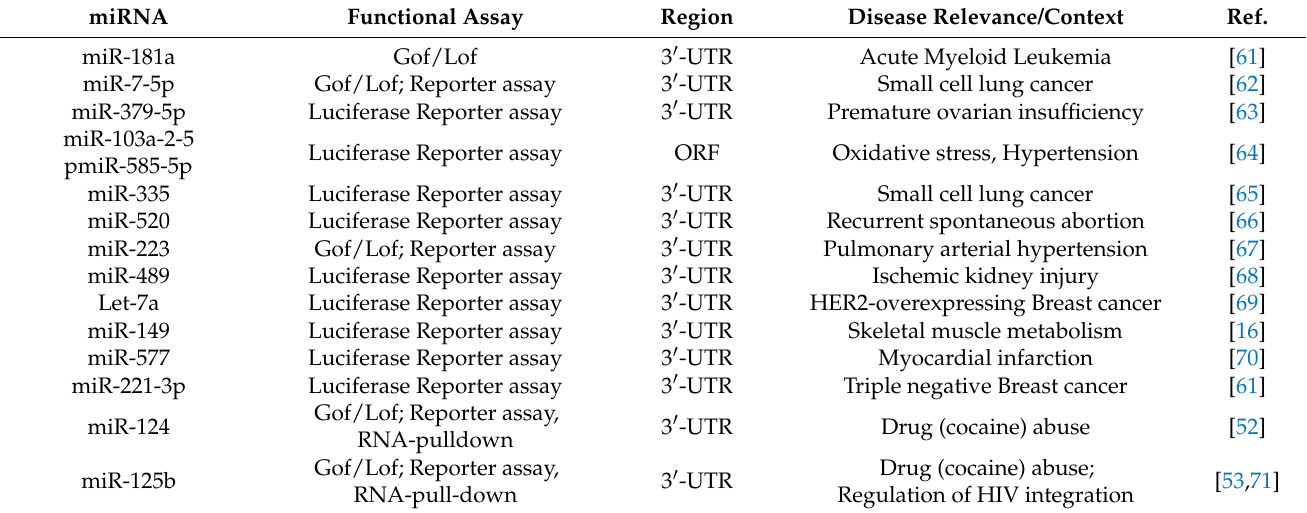
Table 1. List of functionally validated cellular microRNAs that regulate PARP-1mRNA in the context of human diseases.